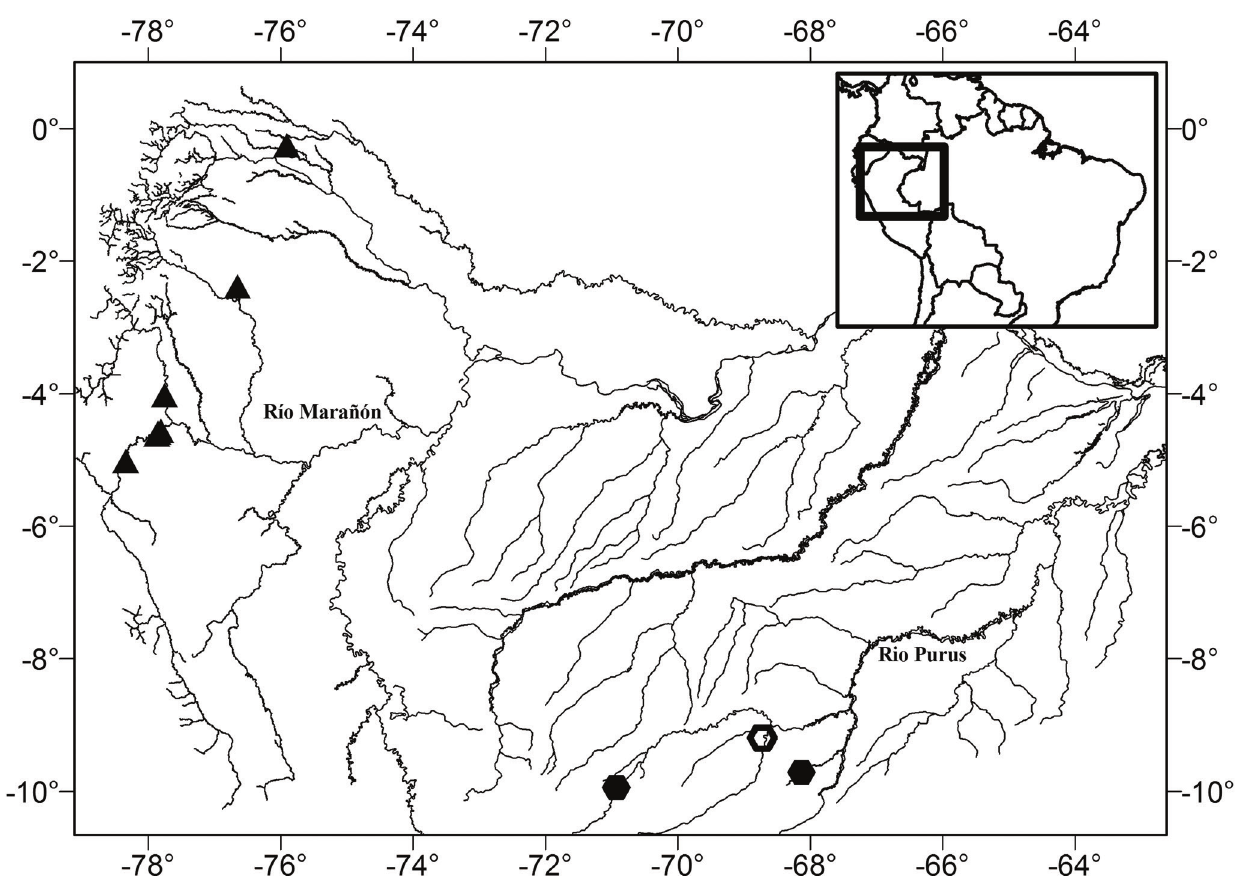
Fig. 7. Distributions of Panaqolus purusiensis (hexagon) and P. nocturnus (triangle). Open symbol: type locality. Symbols may represent more than one locality or